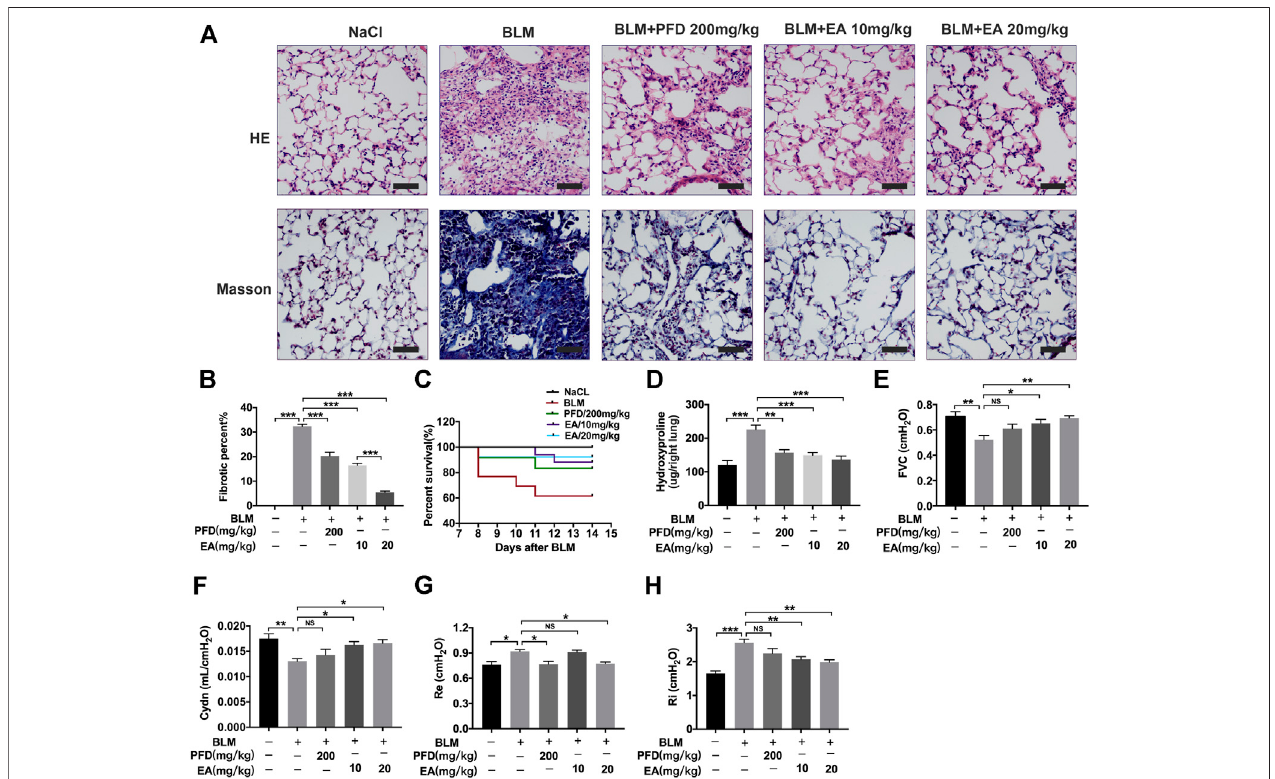
FIGURE1| EllagicacidattenuatesBLM-inducedpulmonary fi brosisinmice.Ellagicacid(10 mg/kg,20 mg/kg)andpirfenidone(200 mg/kg)weregivenorallyonce a day from day 7 – 13 after BLM treatment and lungs were harvested on day 14 (A) Representative images of hematoxylin-eosin (H and E) and Masson staining of lung tissuesections. Scale bars: 50 μ m (B) Percentages of fi brotic area in each group (C) Percentages ofsurviving mice were plotted from day 7 – 13 after BLM treatment (D) Hydroxyproline contents in right lung tissues (E – H) Parameters of lung function such as forced vital capacity (FVC), dynamic compliance (Cydn), expiratory resistance (Re) and inspiratory resistance (Ri). Data ( Figures 1B – H ) are means ± Standard Error of Mean, n (cid:1) 6, * p < 0.05, ** p < 0.01, *** p < 0.001, and NS: nonsigni fi cant (one-way